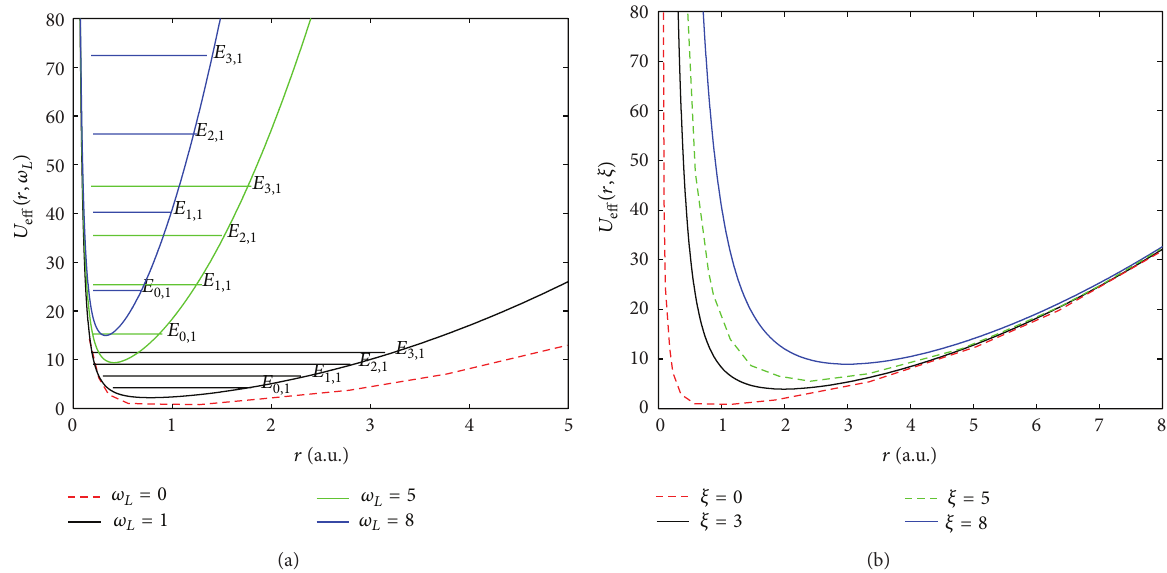
Figure 2: The Schr¨odinger effective potential function and corresponding bound state energy levels ( 𝐸 𝑛𝑚 ) in low vibrational (𝑛 = 0,1,2,3) and rotational (𝑚 = 1) levels for (a) 𝜔 𝐿 = 0,1,5,8 with 𝜉 = 0 . (b) 𝜉 = 0,1, 5, 8 and with 𝜔 𝐿 = 0 (color online). Here, 𝜇 = ℎ = 1